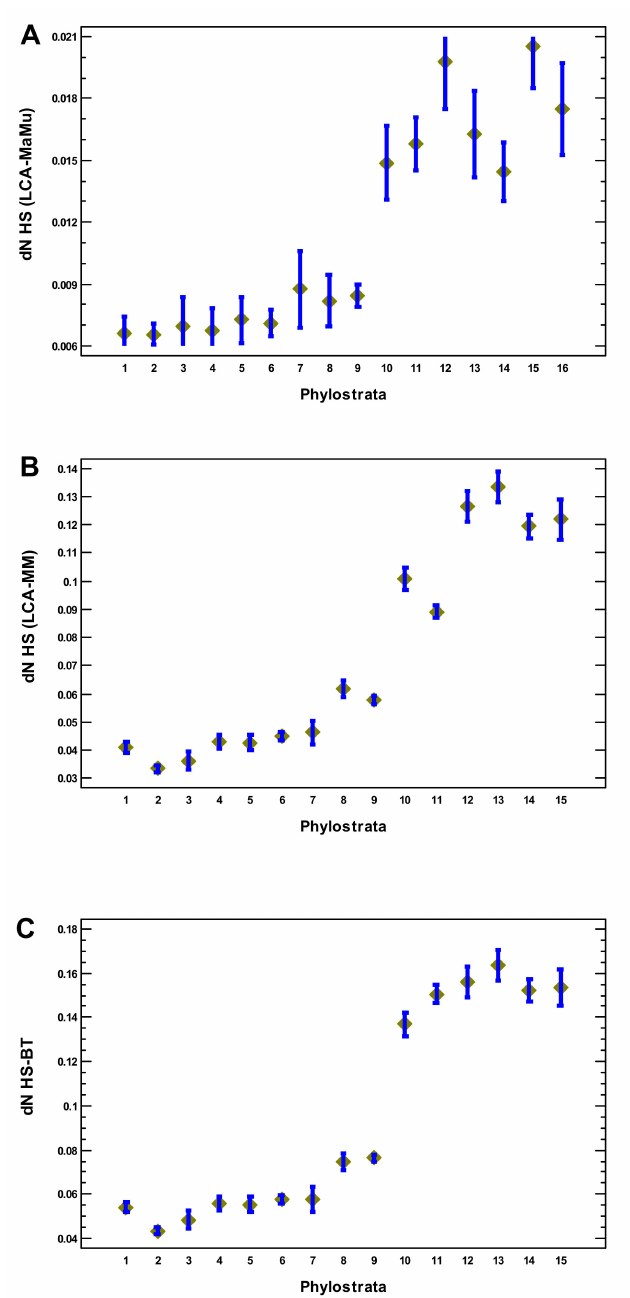
Figure 9. Phylostratic course of protein evolutionary rate ( dN ). ( A ) In the phyletic line from the common ancestor with macaque to the human. ( B ) In the phyletic line from the common ancestor with mouse to the human. ( C ) In the direct human–cow comparison. Means with LSD intervals ( p < 0.05). (1—cellular organisms; 2—Eukaryota; 3—Opisthokonta; 4—Metazoa; 5—Eumetazoa; 6—Bilateria; 7— Chordata; 8—Vertebrata; 9—Euteleostomi; 10—Tetrapoda; 11—Amniota; 12—Mammalia; 13—Theria; 14—Eutheria; 15—Boreoeutheria;